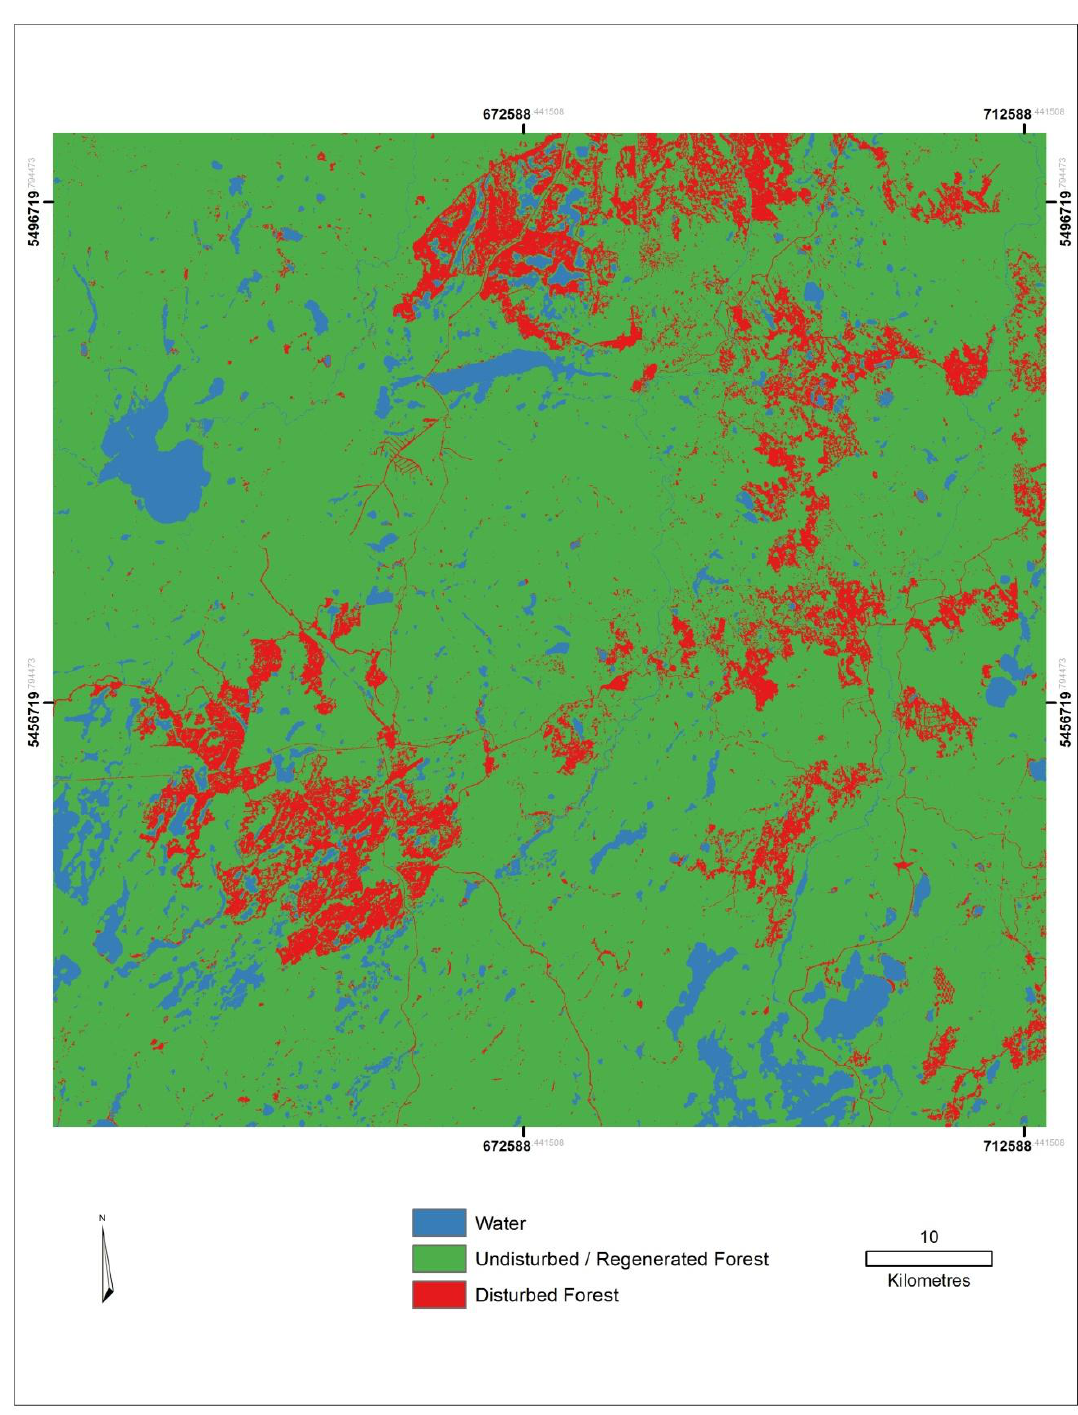
Figure 3. 1986 land classification